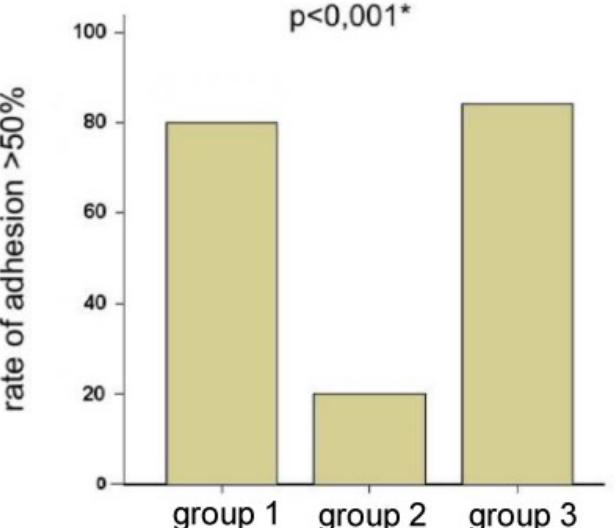
FIGURE 5 - Comparison of the rates of adhesion over 50%. * Difference between Group 2 and Groups 1 and 3 is statistically significant (p<0.001)